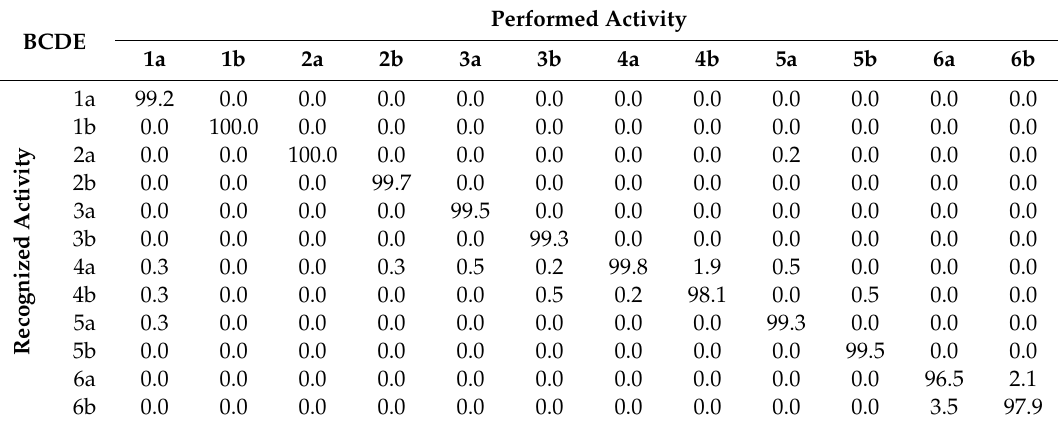
Table A11. Matrix of recognition errors (in %) of 12 motor activities 1a ÷ 6b in test set for all volunteers together for sensor